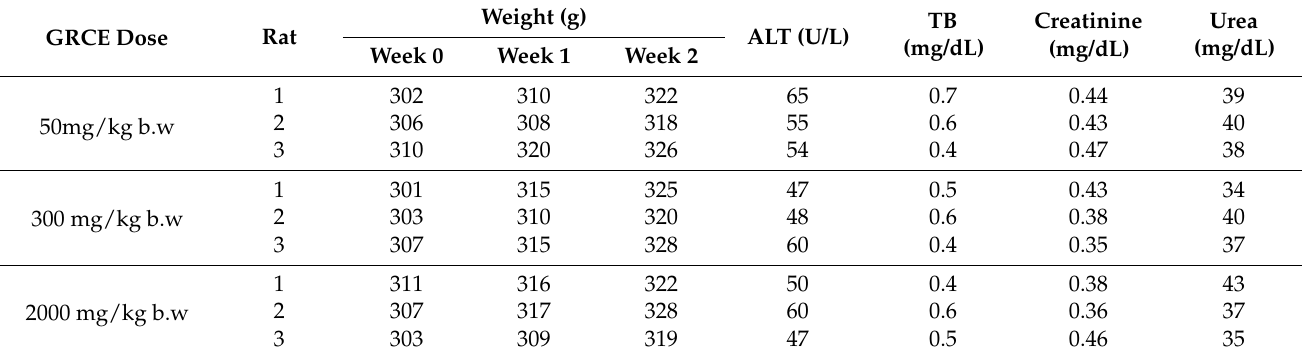
Table 4. Weight and biochemical evaluation for toxicity.